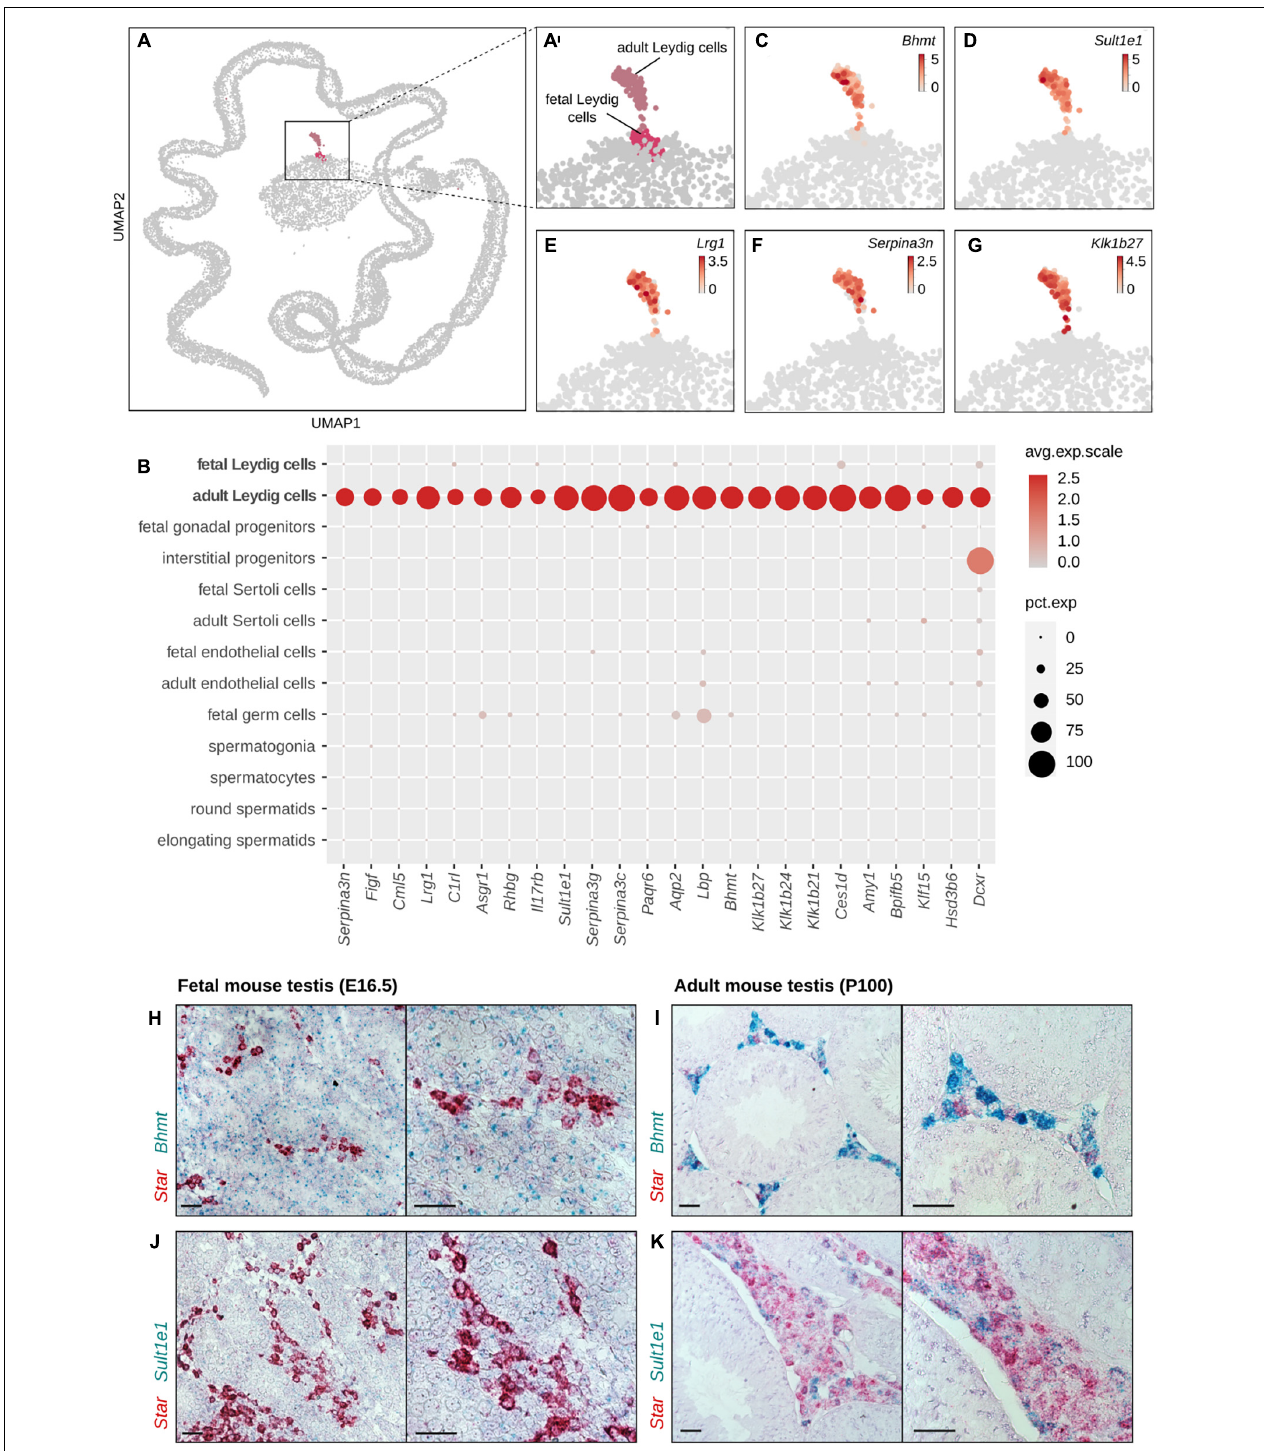
FIGURE 5 | Identification of genes labeling ALCs. (A,A (cid:48) ) UMAP representation of single-cell transcriptomes highlighting the two Leydig cell populations: fetal Leydig cells (FLCs) in pink and adult Leydig cells (ALCs) in pale violet. The other populations of the testis are colored in gray. (C–G) Enlargement on the UMAP representation colored according to the normalized expression of selected ALC-specific candidate marker genes, like Bhmt (C) , Sult1e1 (D) , Lrg1 (E) , Serpina3n (F) , and Klk1b27 (G) . (B) Dotplot displaying the scaled expression of the top 25 ALC-specific candidate genes. (H–K) In situ hybridization assay by RNAscope labeling in red Star , a known marker of Leydig cells, and in green the ALC marker Bhmt (H,I) and Sult1e1 (J,K) in adult mouse testis at P100 (H,J) and in embryonic mouse testis at E18.5 (I,K) . The colocalisation of the red and green probes indicate a co-expression of the two genes in the Leydig cells. The black scale bar corresponds to 100 µ m.